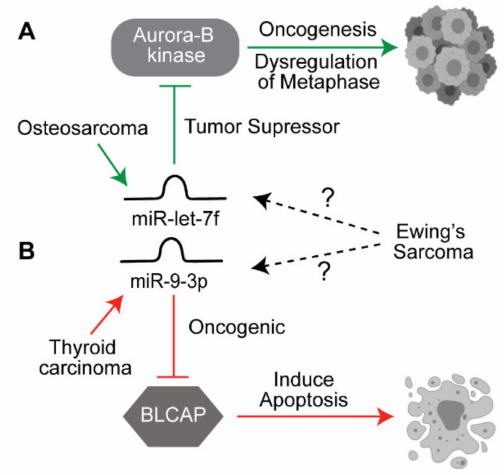
Figure 2. Potential link between miRNAs identified in other cancers. ( A ) miR-let7f acts as a tumor suppressor miRNA by downregulating the oncogene Aurora B kinase in osteosarcoma. ( B ) miR-9-3p acts as an oncogenic miRNA by suppressing BLCAP which is required for inducing apoptosis in thyroid cancer. Both of these target genes are similarly affected in ES, but the role of these miRNAs is not yet elucidated in ES. The solid arrows indicate known pathways, the dotted arrows indicate yet to be explored